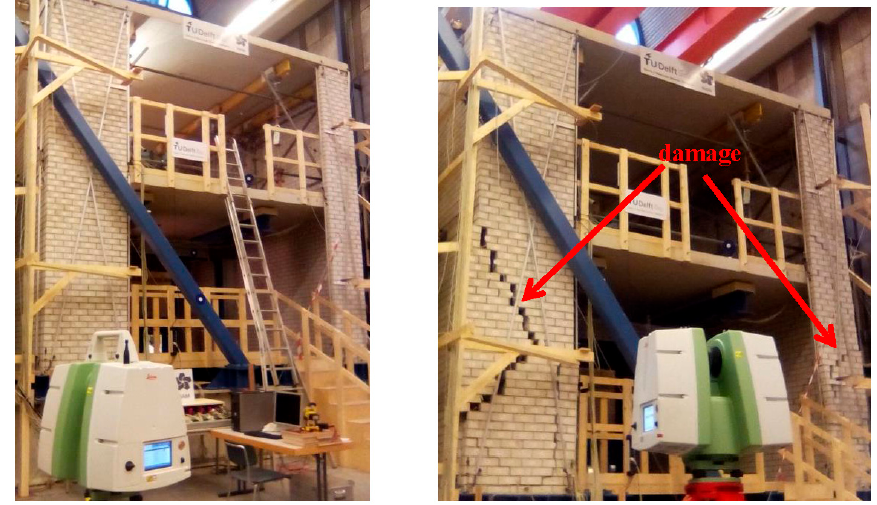
Figure 4. On the left : the masonry wall before the seismic testing; on the right : the damaged masonry wall after the seismic testing.